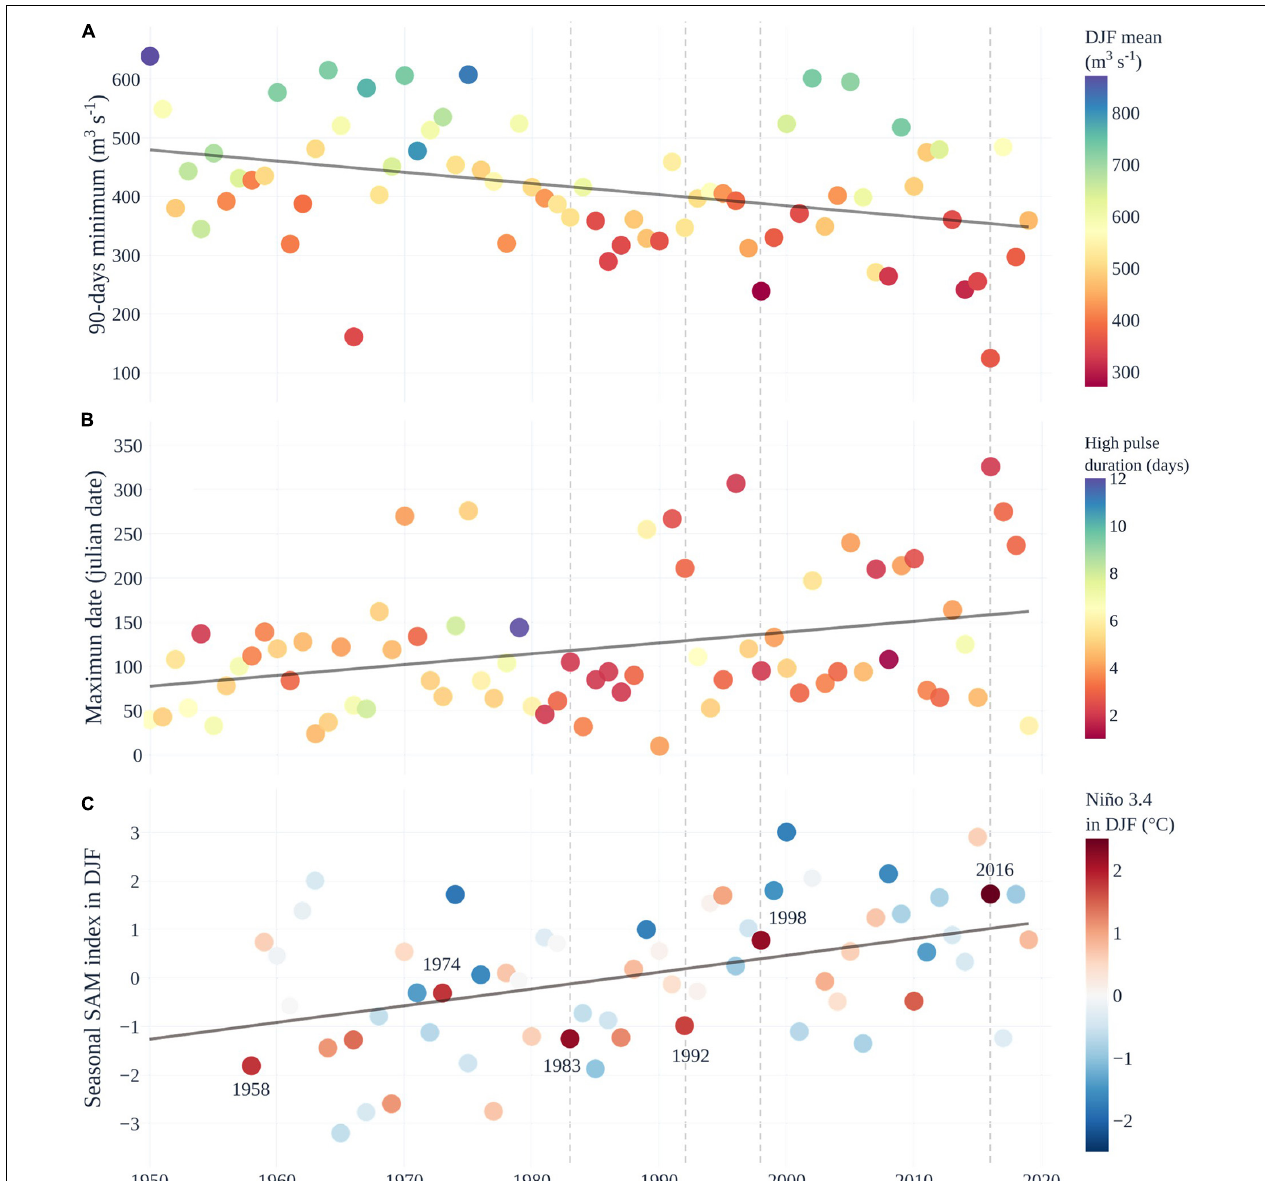
FIGURE 5 | Natural streamflow regime trends of the Puelo River and the climatic context. (A) Minimum annual streamflow in a 90-day window. The color palette in (A) represents the average streamflow during the summer season (DJF period). (B) Julian date of the maximum annual streamflow and high pulse duration (defined by 75th percentile; color palette). The first Julian day corresponds to the first day of the water year (April 1). (C) Southern Annular Mode (SAM) index during DJF as in Marshall (2003). The color palette represents the Niño 3.4 index during DJF of the HadISST1 data set. The segmented vertical lines indicate the main ENSO